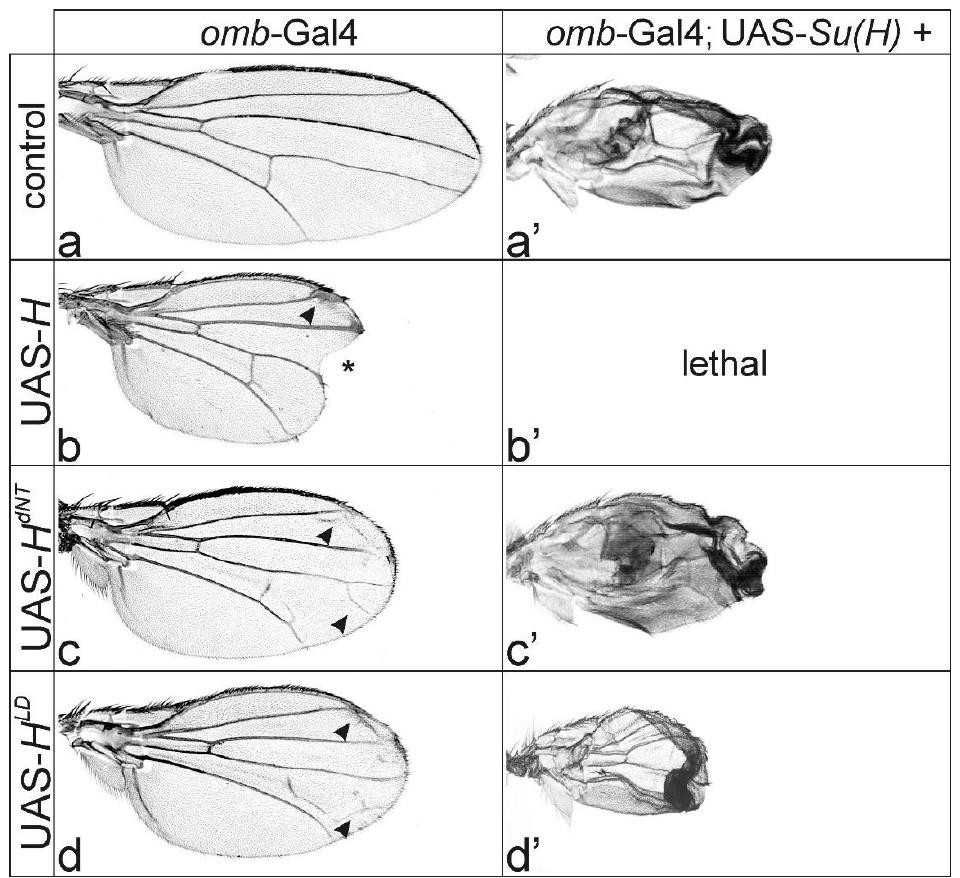
Figure 2. Overexpression of H protein variants in the central wing anlagen using omb -Gal4. ( a – d’ ) The transgenes, as indicated, were overexpressed in the central part of the wing anlagen using omb -Gal4 at 20 °C. Female wings are shown. ( a ) UAS-GFP served as control. ( b ) Wing incisions (asterisk), proliferation defects, and vein thickening (arrowhead) were typical consequences of an inhibition of Notch activity resulting from overexpression of wild type H protein. ( c , d ) Overexpression of either H dNT or H LD mutants did not affect the wing margin. Note, however, ectopic wing vein formation (arrowheads mark examples) and slightly reduced wing size. ( a’ – d’ ) Combined overexpression of Su(H) and H variants. ( a’ ) Whereas the overexpression Su(H) within the wing anlagen resulted in crumbled wings, a combination with wild type H was lethal as a consequence of excessive repressor complex formation ( b’ ) [9,40,52,53]. In combination with either ( c’ ) H dNT or ( d’ ) H LD , however, the wings resembled those of the sole Su(H) overexpression.